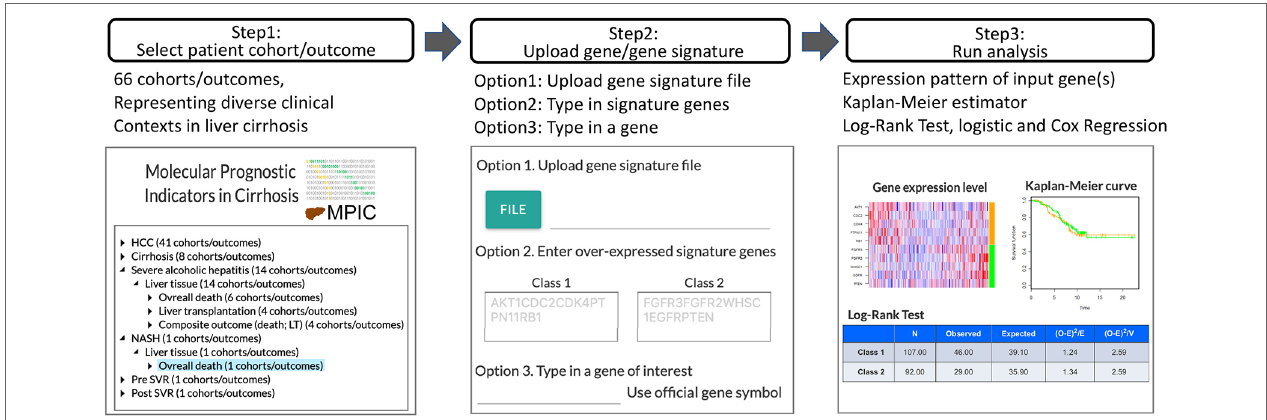
FIGURE 1 | Workflow of MPIC for clinical context-specific in silico prognostic biomarker validation in